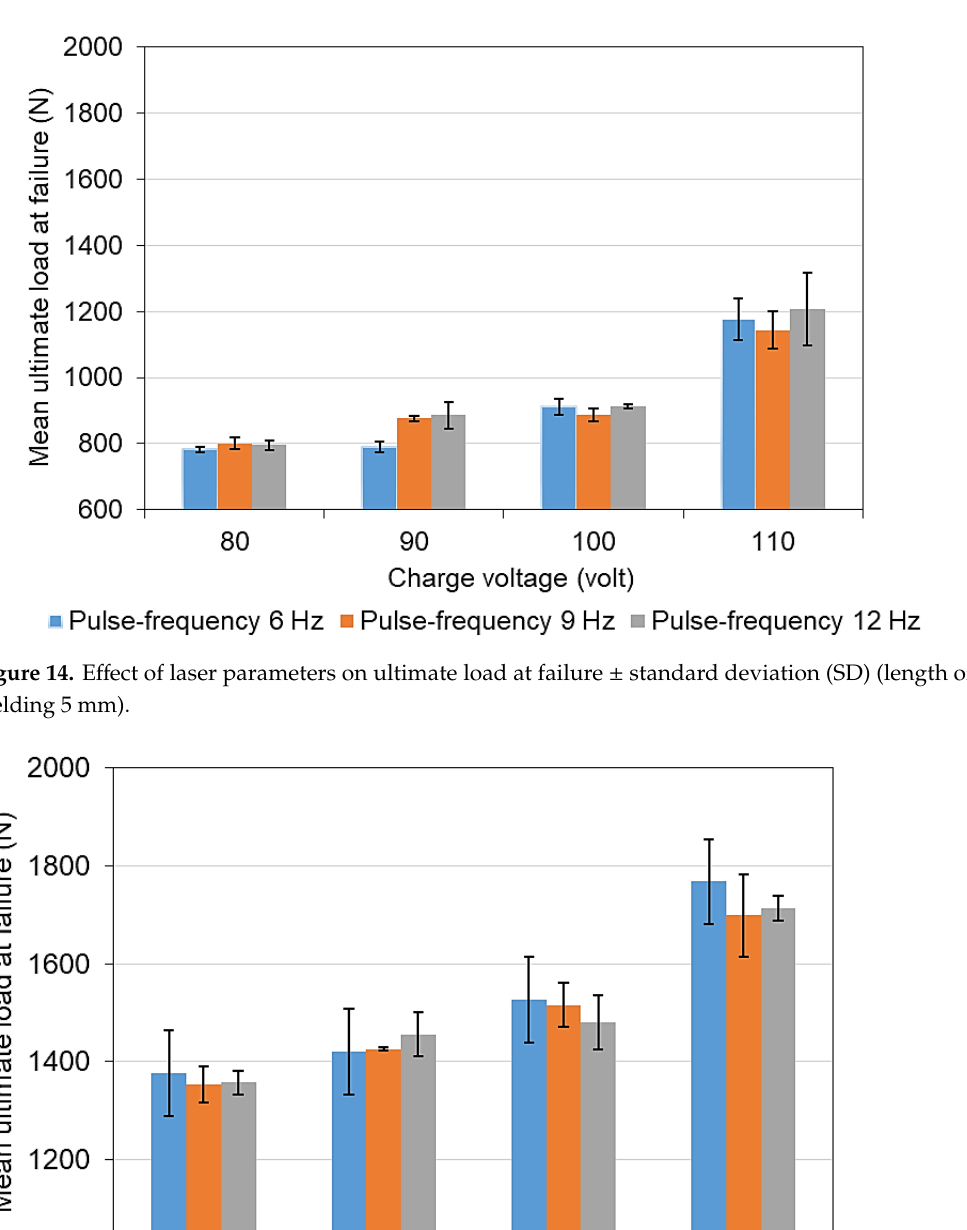
Figure 16. Effect of laser parameters on ultimate load at failure ±SD (length of welding 15 mm). 4.4. Optimal laser parameters Adjusting the laser parameters and the welding length, the experimental results, considering the weld appearance and ultimate load at failure, can be analyzed to find the optimal laser parameters for welding on stainless steel 316L. In this study, the criteria for selecting the optimal laser parameters was designed to give a better ultimate load at failure or acceptable ultimate load at failure. The results